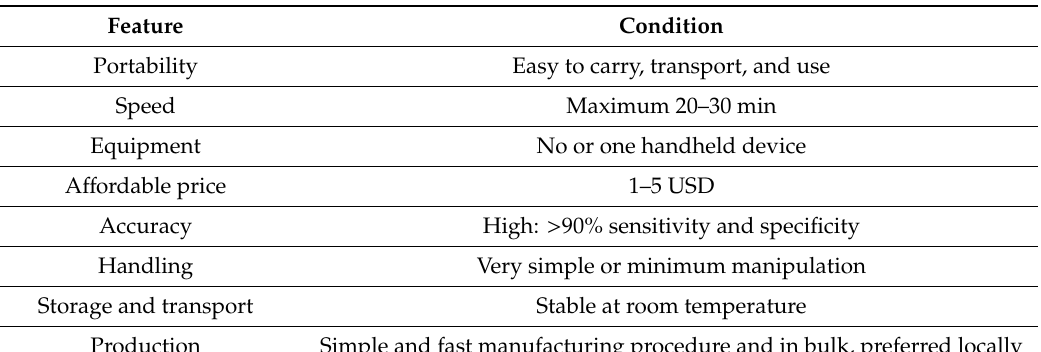
Table 6. Characteristics of Point-of-Need Diagnostic